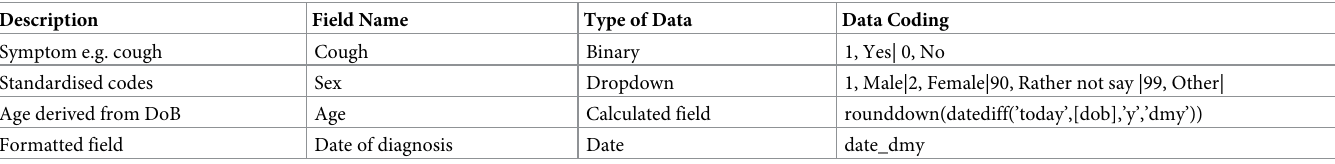
Table 1. Examples of levels of standardisation in TBDBT, for patient age, gender, and date of